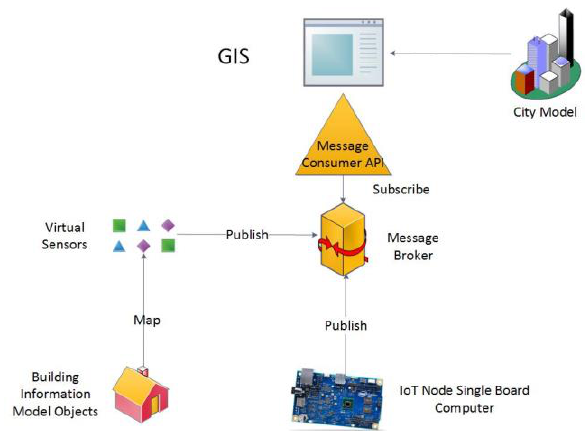
Figure 2: GIS-BIM-IoT Nodes Integration